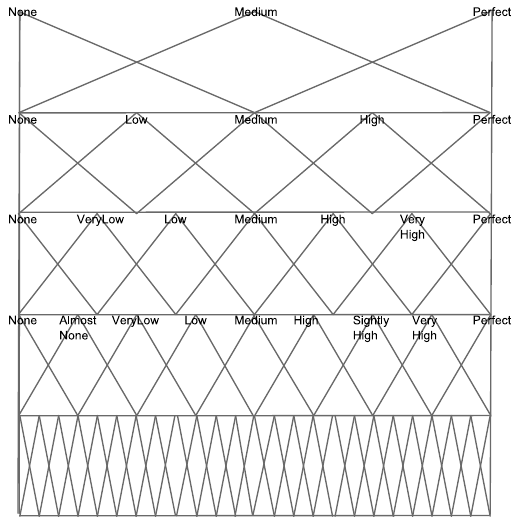
Fig. 7. Linguistic term sets used in the